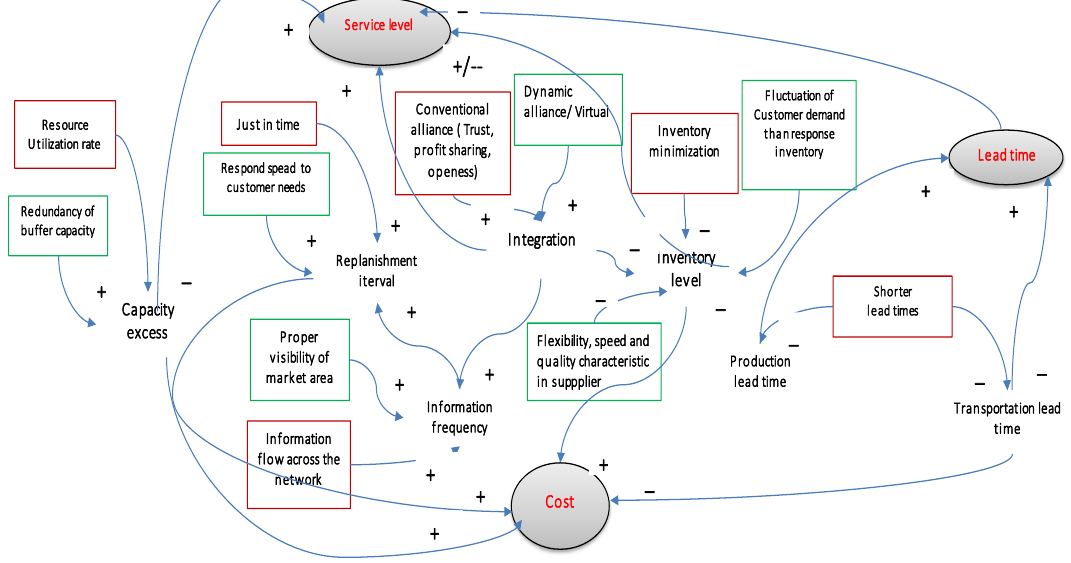
Figure 4. Conceptual model with lean and Agile inventory attributes relationship